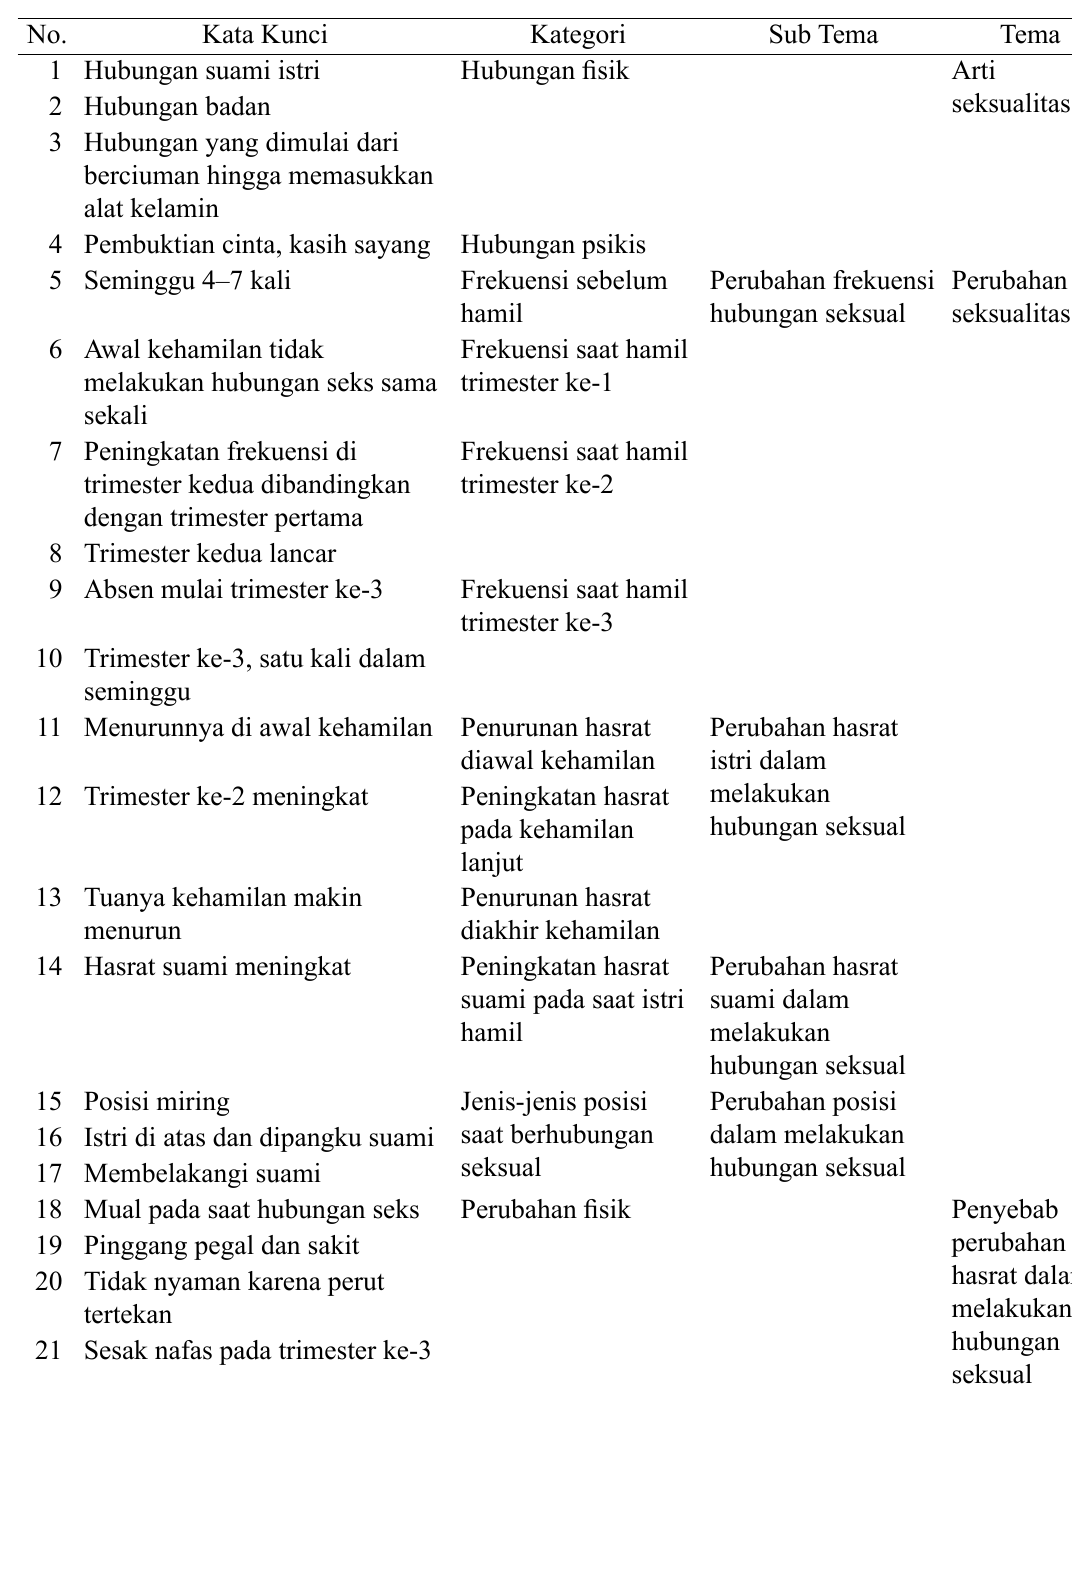
Tabel 1. Proses pembentukan tema